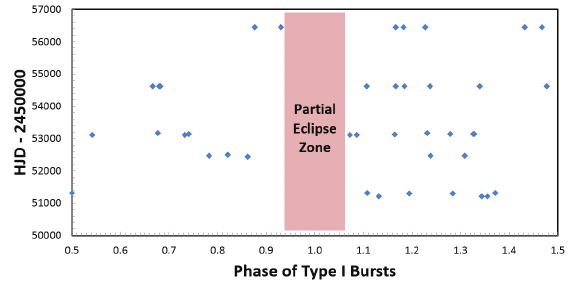
Figure 7: Distribution of 40 type I bursts as a func- tion of phase. No bursts occurred between phase 0.93 and 1.07 due to partial eclipses of the accretion disk by the